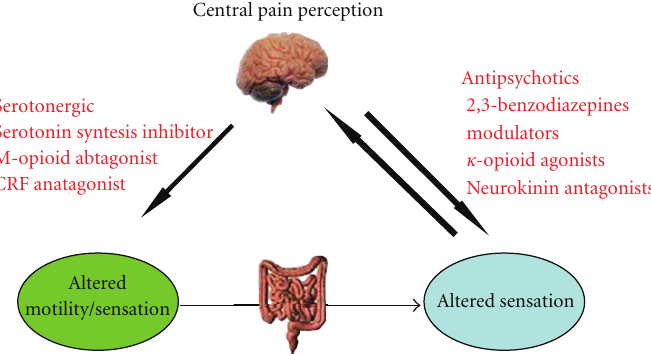
Figure 1: Brain-gut axis and pharmacological approaches for irritable bowel syndrome. This figure shows schematically the targets of the current and novel psychopharmacological therapies for irritable bowel syndrome. The reason to use these approaches is the presence of bidirectional connections between brain and gut: according to this pathophysiological model, emotional and cognitive centers of the brain, particularly those involving pain perception, are linked with peripheral functioning of gastrointestinal tract, and vice versa, thus, conditioning intestinal motility, sensation, and